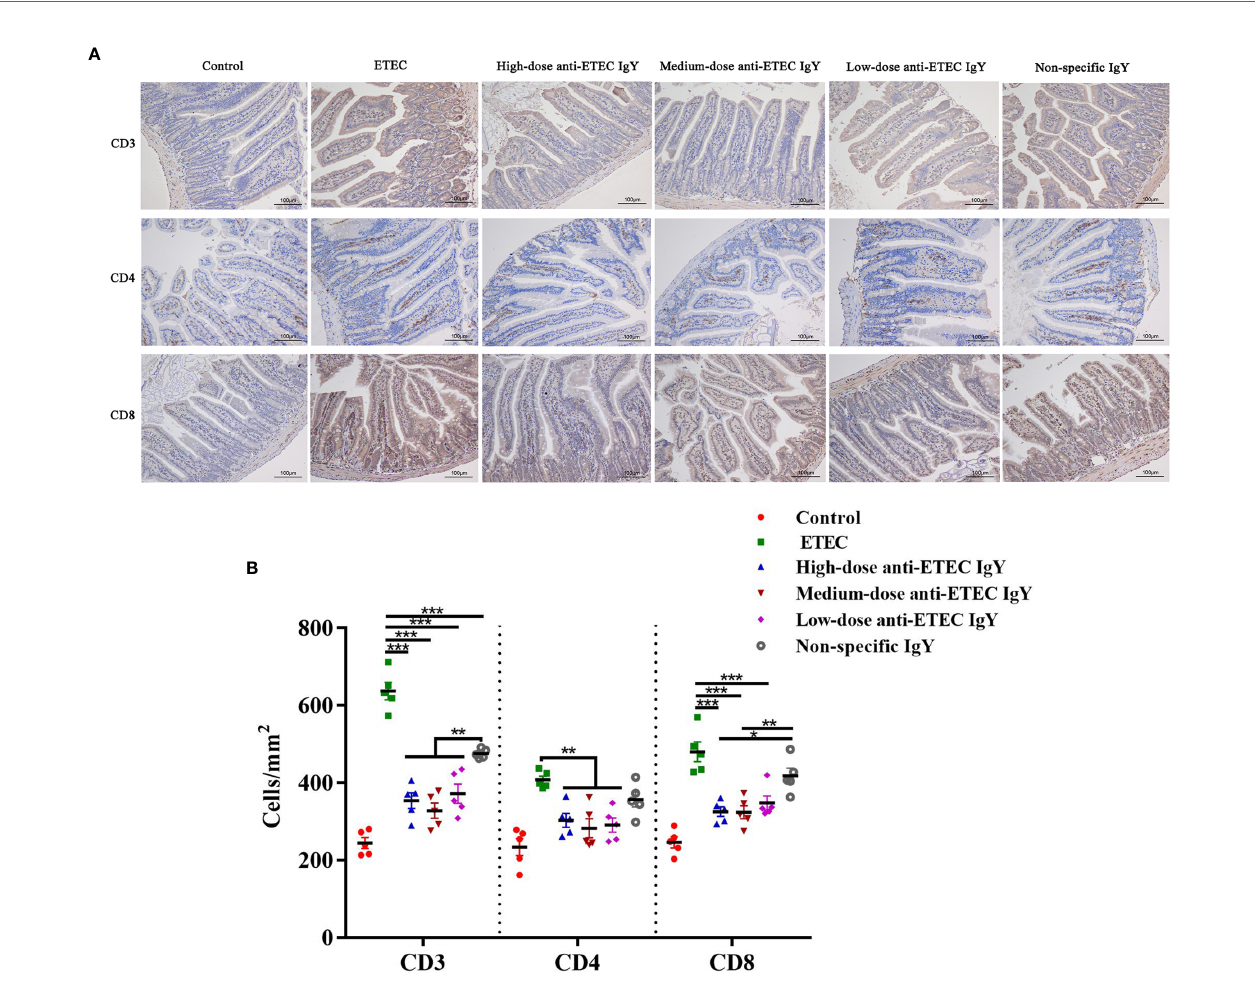
FIGURE 9 | (A) Representative images of the immunohistochemical localization of lymphocytes in the jejunum of control (neither IgY nor ETEC infection) mice, ETEC-infected mice, ETEC-infected mice treated with high-, medium- or low-doses anti-ETEC IgY or ETEC-infected mice treated with non-speci fi c IgY. The lymphocyte markers and nuclei are stained brown and blue, respectively. (B) Quanti fi cation of lymphocyte populations in the jejunum of mice in different groups. Values are least squares means ± SEM, n=5. * P < 0.05, ** P < 0.01, *** P <